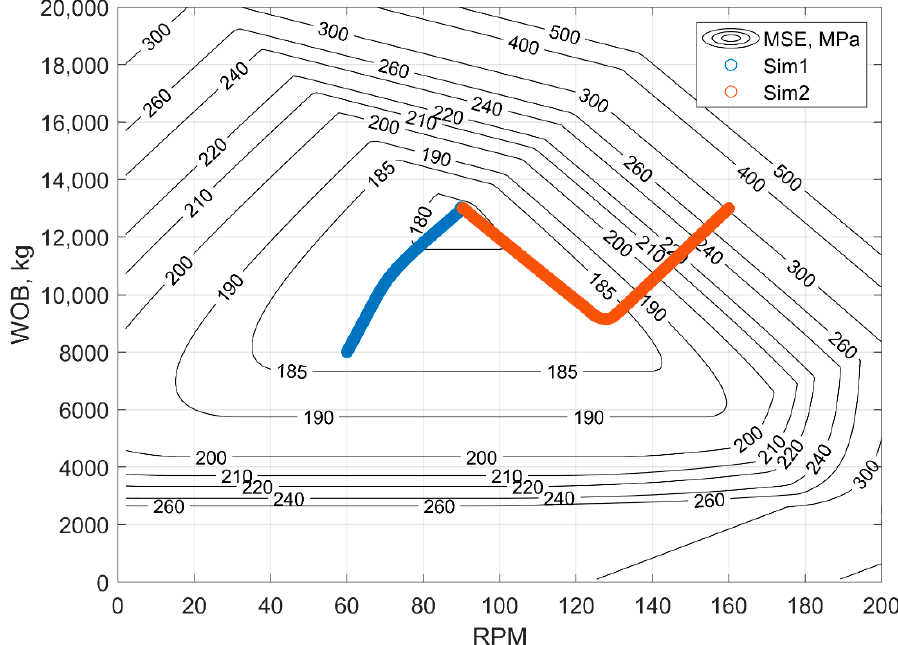
Figure 13. Contour plot of the MSE values for drilling in formation A , together with the 𝑊𝑂𝐵(cid:3364)(cid:3364)(cid:3364)(cid:3364)(cid:3364)(cid:3364)(cid:3364) and 𝑅𝑃𝑀(cid:3364)(cid:3364)(cid:3364)(cid:3364)(cid:3364)(cid:3364)(cid:3364) values for Simulations 1 and 2.